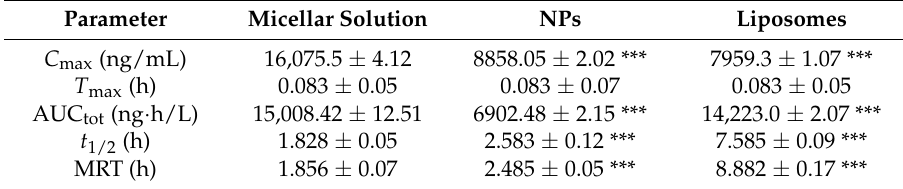
Table 2. Pharmacokinetic parameters for different CBZ formulations with a dose of 15 mg/kg cabazitaxel after tail vein injection. Data are presented mean ± SD ( n = 6).